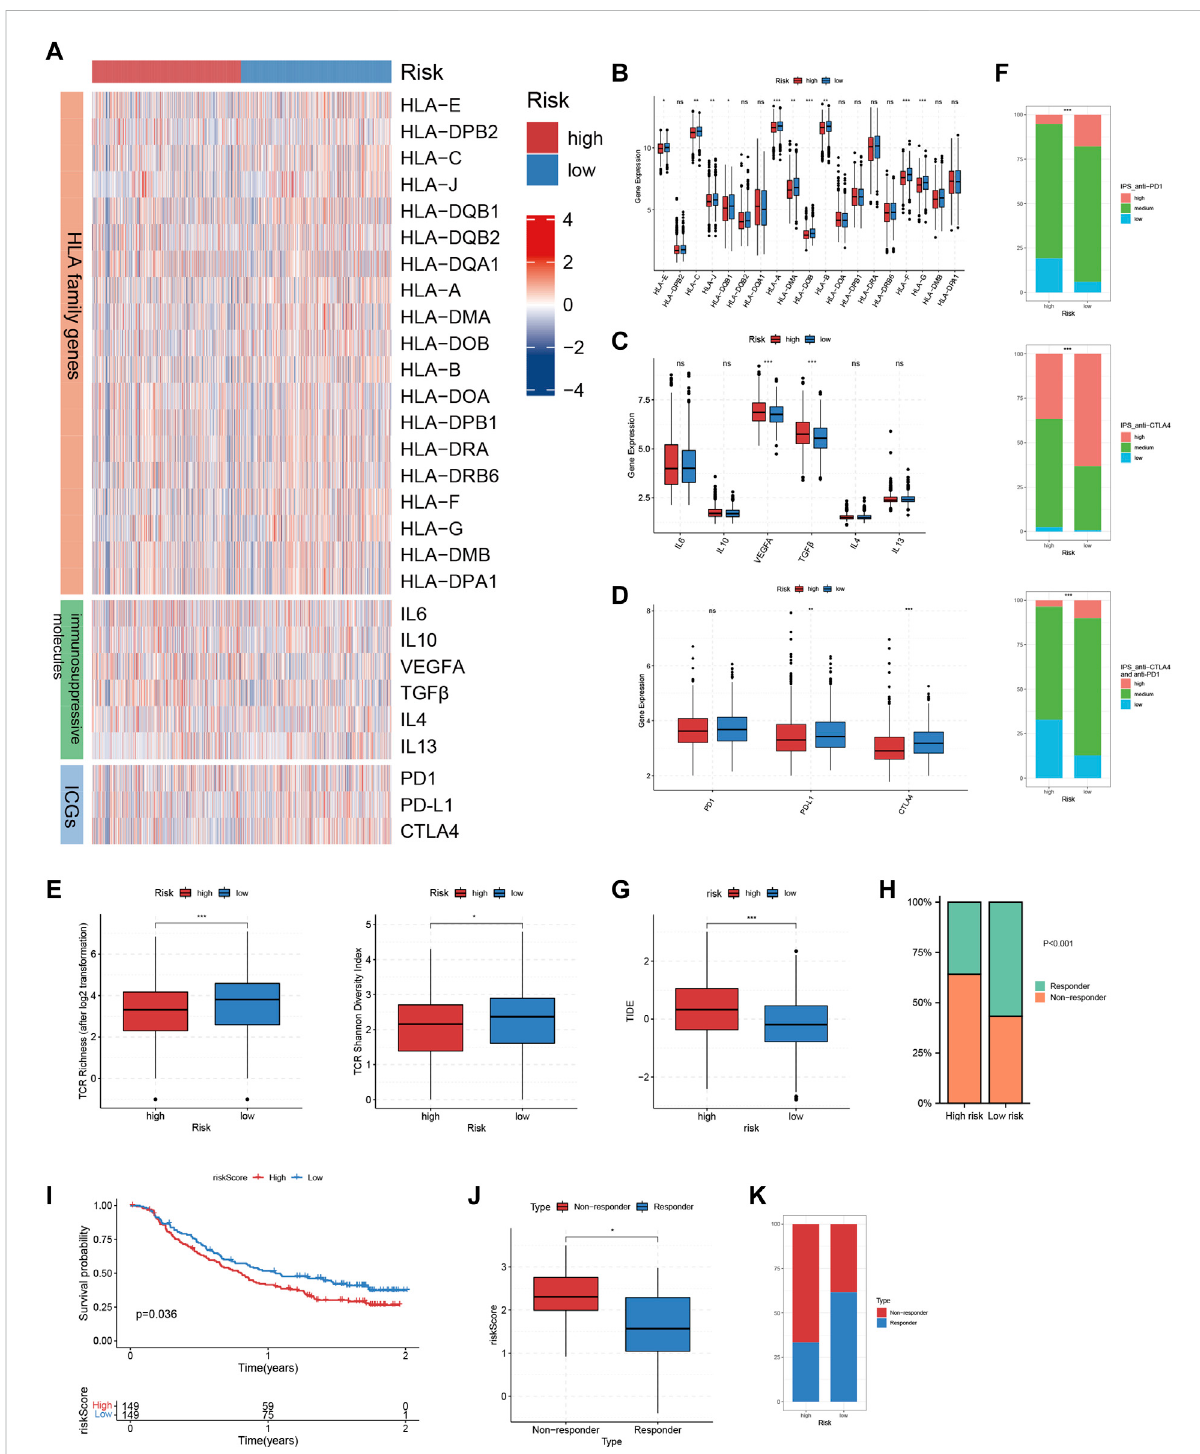
FIGURE 7 Immunotherapeutic sensitivity analysis of TRMRG risk score signature. (A) Heatmap showing the expression patterns of HLA family genes, immunosuppressivemoleculesandICGsbetweenhighandlowriskpatients. (B – D) Barplots comparingexpressiondifferencesofHLAfamilygenes, immunosuppressive molecules and ICGs between highand low risk patients. (E) DifferencesinTCR richness and diversity between high and low risk patients. (F) Bar plots showing the frequencies of high, medium, low level IPS scores for anti-PD1 treatment, anti-CTLA4 treatment and the combinatorial therapy in high and low risk patients. (G) Box plot comparing differences in TIDE scores between high and low risk patients. (H) Frequenciesofrespondersandnon-responderstoICItherapiesforpatientswithhighandlowrisk. (I) Kaplan-MeierplotshowingtheOSforhighand low risk patients after receiving anti-PD-L1 treatment in IMvigor210 cohort. (J) Box plot comparing the risk scores for responders and non- responsers in GSE78220. (K) Frequencies of responders and non-responders in high and low risk group in GSE78220. Statistical Signi fi cance: * p < 0.05; ** p < 0.01; *** p < 0.001; ns: not signi fi